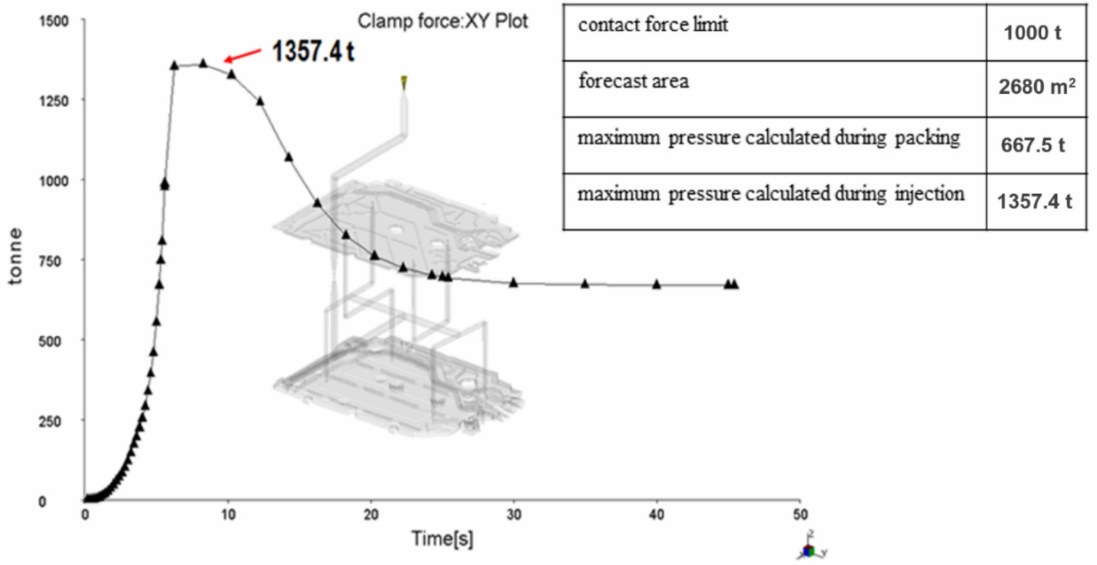
Figure 10. Image of the pressure distribution in the seat at the time of filling of 98%.